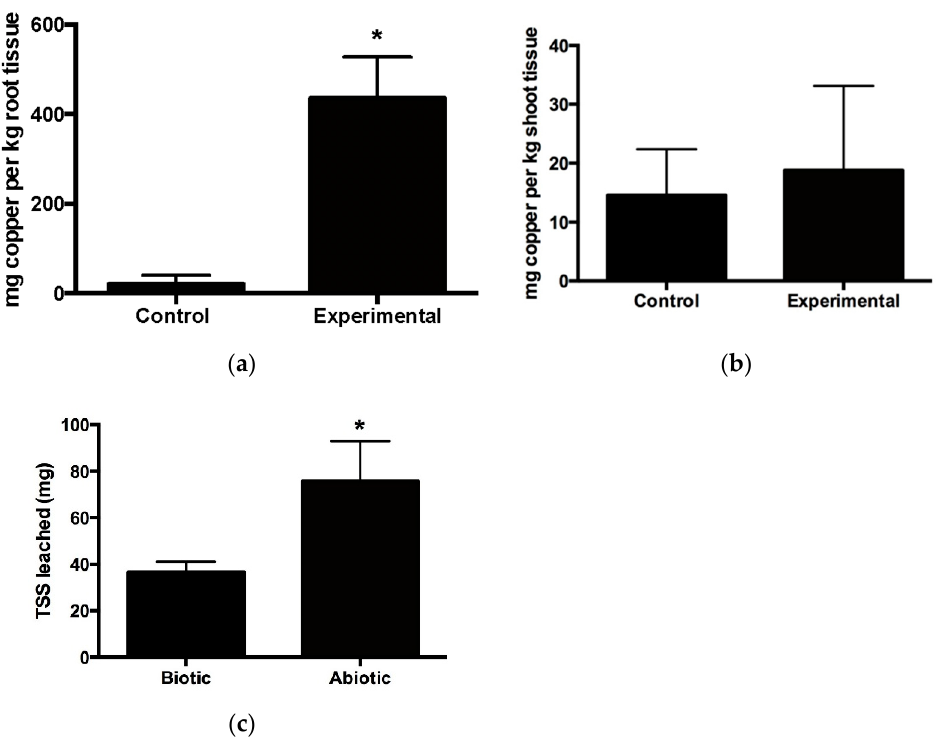
Figure 2. Copper accumulation in vetiver grown (biotic columns) in control soil versus stamp sand in ( a ) root and ( b ) shoot. “Control” = vetiver grown in control soil; “Experimental” = vetiver grown in stamp sand. ( c ) Total suspended solids (TSS) in leachate (mg) between biotic and abiotic columns. Error bars show standard deviation (n = 6). (*) indicates p -value = < 0.05, using t -test with Welch’s correction and α = 0.05.